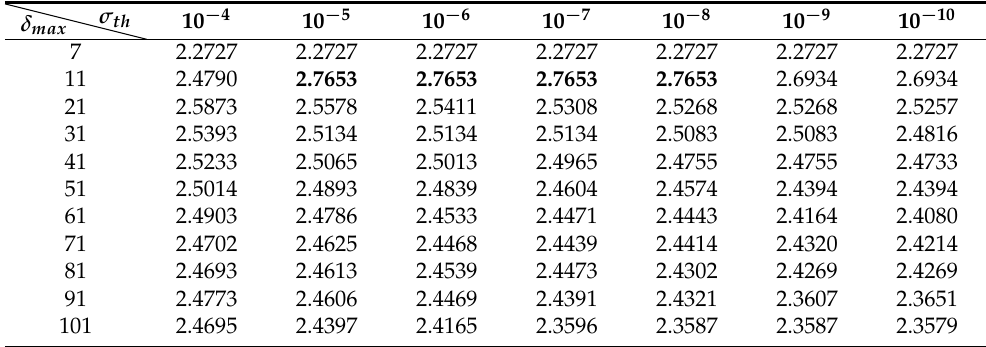
Table 2. The estimated multi-spectral fractal dimension (MFD) of multi-spectral fractal image with low generated complexity ( H =